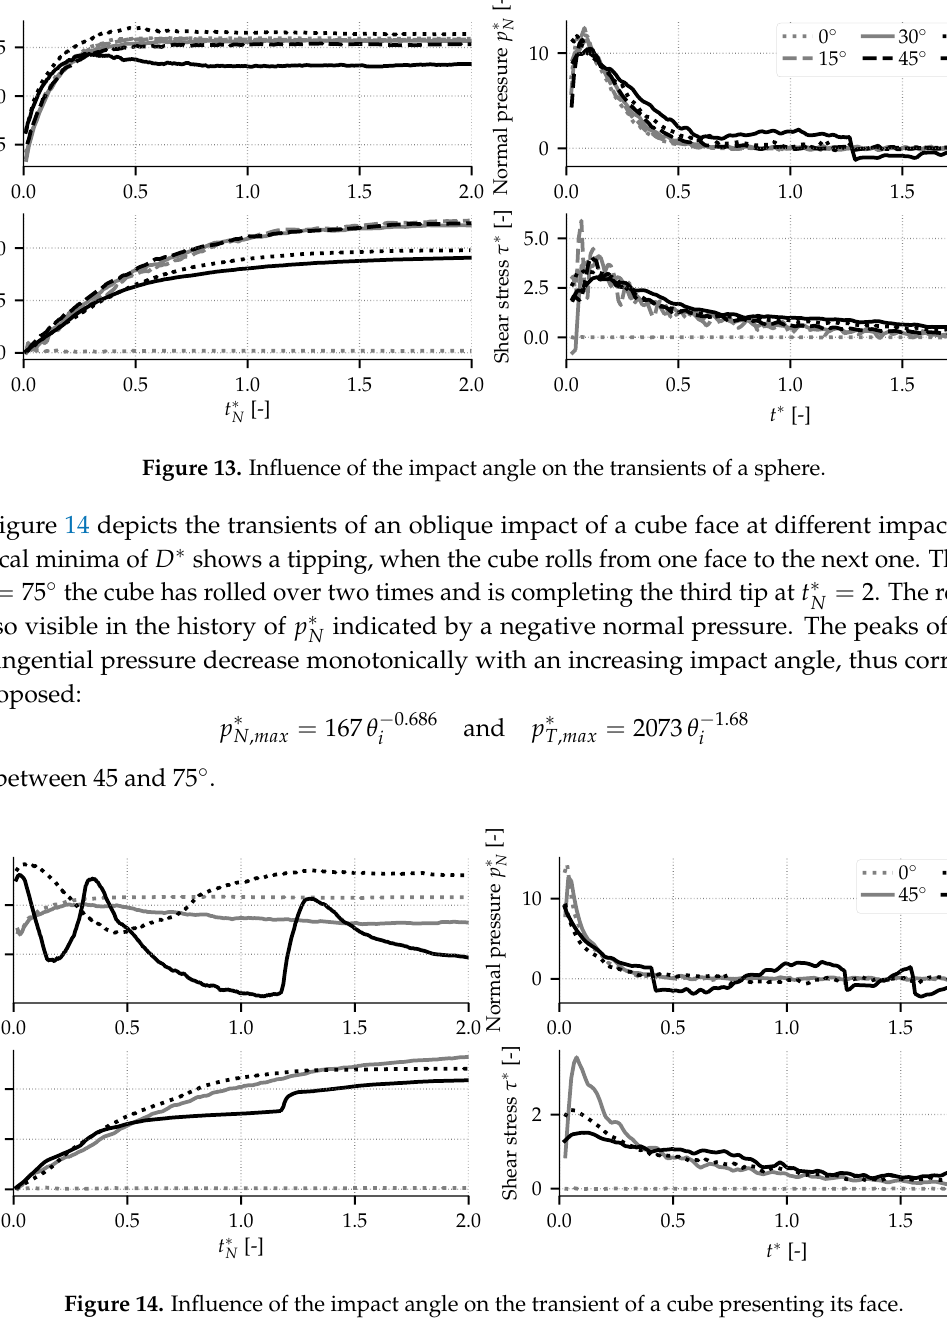
the final values are confined to a regime between 0.4 and